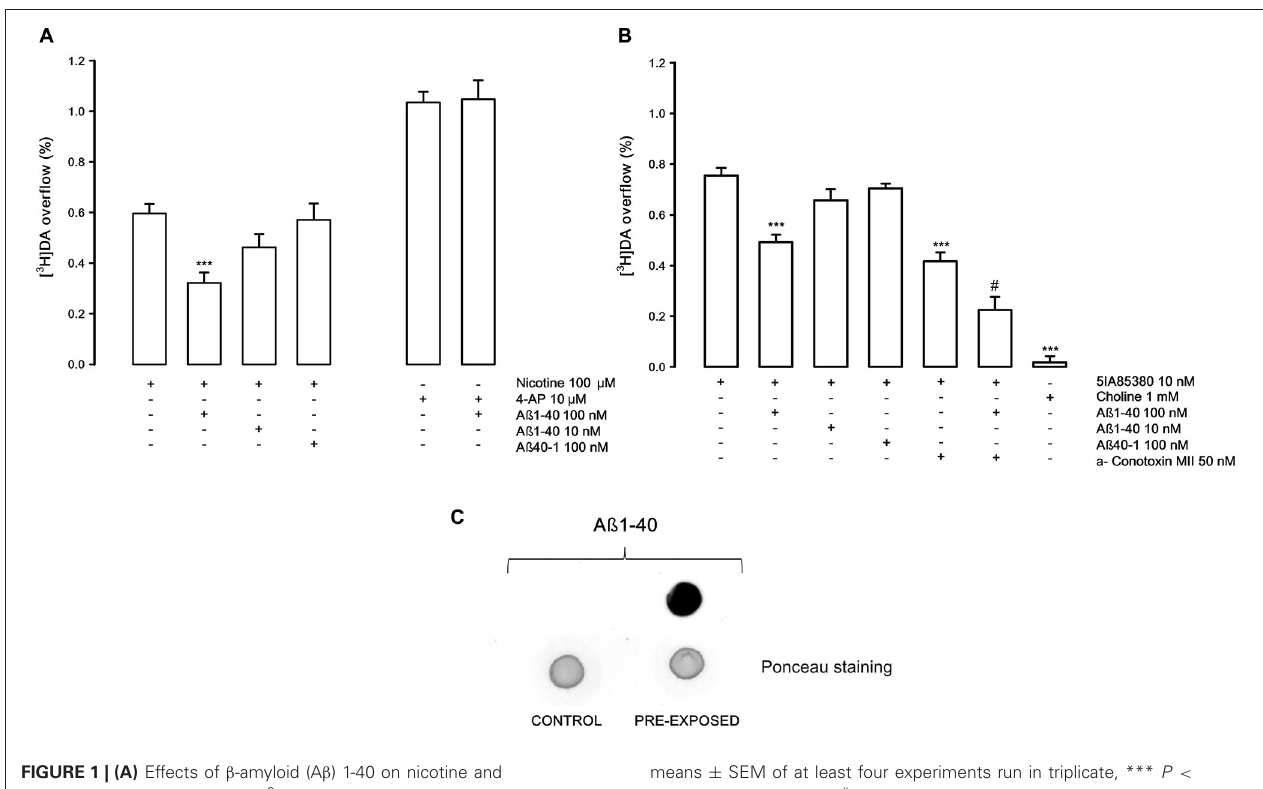
FIGURE 1 | (A) Effects of β -amyloid (A β ) 1-40 on nicotine and 4-aminopyridine (4-AP)-evoked [ 3 H]DA overflow from rat NAc synaptosomes. Data are means ± SEM of at least four experiments run in triplicate, *** P < 0.001 versus nicotine. One-way ANOVA followed by Bonferroni post-hoc test. (B) Effects of A β 1-40 on [ 3 H]DA overflow evoked by 5IA85380, alone or in presence of α -conotoxin MII. Data are